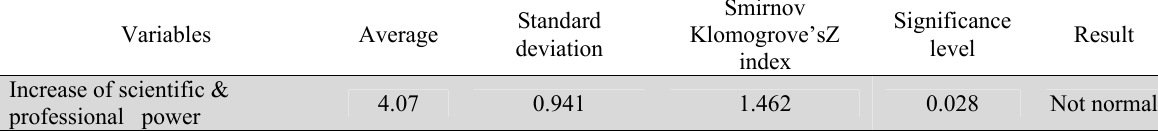
Smirnov Klomogrove’s test for the results of Iran's membership in WTO